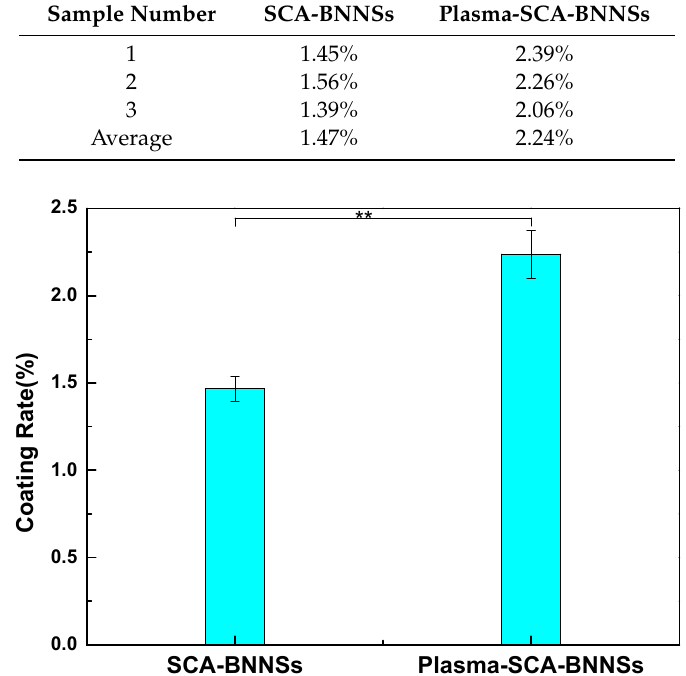
Figure 11. Coating rate of SCA treated BNNSs (SCA-BNNSs), and plasma and SCA treated BNNSs (plasma-SCA-BNNSs). ** p < 0.01. The interval between each treatment and test is less than 1 h.